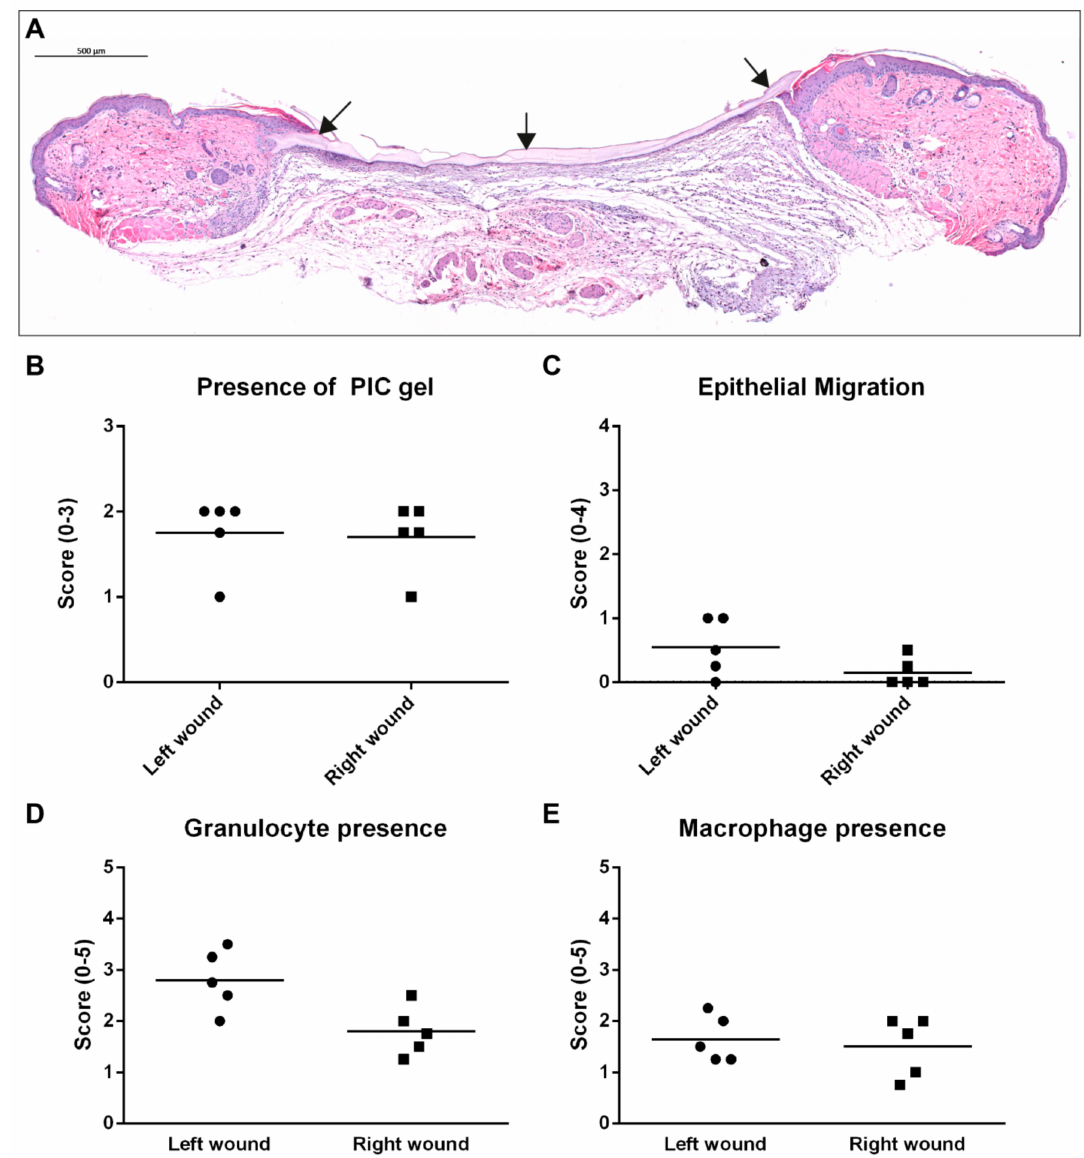
Figure 2. Results of histological analysis in the imaging study, taken at three days post-injury. A distinction was made between left and right wounds. ( A ) This HE-stained section is positioned closer to the edge of a wound and shows a clear layer of PIC gel (indicated by black arrows) on top of the wound even after the washing procedure. Scale bar indicates 500 µ m. ( B ) The presence of PIC gel was scored in all wounds and was mostly awarded with a score 2 (large volumes of PIC gel positioned topically). ( C ) The migration of epithelium was mostly not initiated yet on day 3. ( D ) More granulocytes were present in left-wounds compared to right-wounds on average. Total granulocyte scores were also higher compared to the main wound healing study. ( E ) The presence of macrophages was similar in left and right